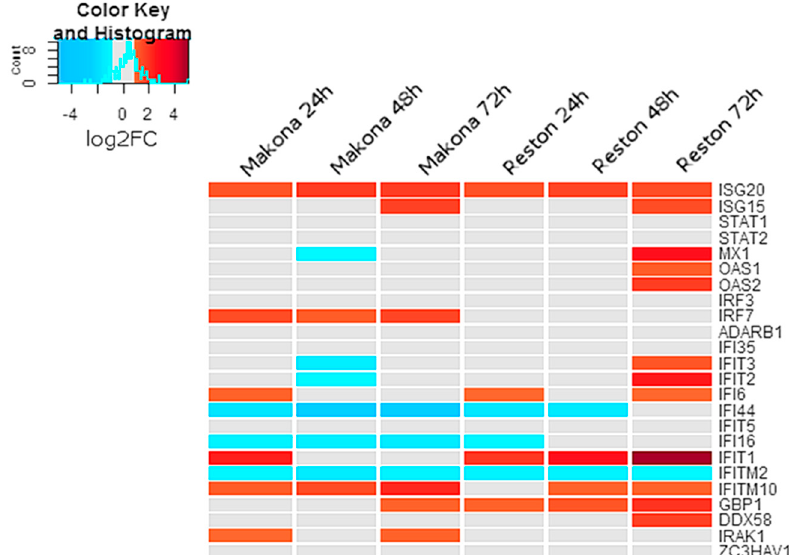
Figure 3. Heatmap showing log2FC in transcript abundance of transcripts encoding genes identified as interferon-stimulated genes (ISG) compared with mock-infected cells. A colour scale bar is provided to aid interpretation, showing change in colour from − 5 to + 5 with threshold values set at − 4 (“Blue”) and + 4 (“Red”). A range of − 1 to + 1 log2FC indicated no change compared with mock-infected cells and is indicated by “Gray”. A histogram is shown in the scale bar, indicating the frequency that genes fall into a particular zone of the colour scale. The histogram indicated that the greatest numbers of transcripts in this heatmap were close to 0 log2FC, with most falling in the range of − 2 to + 2 log2FC.